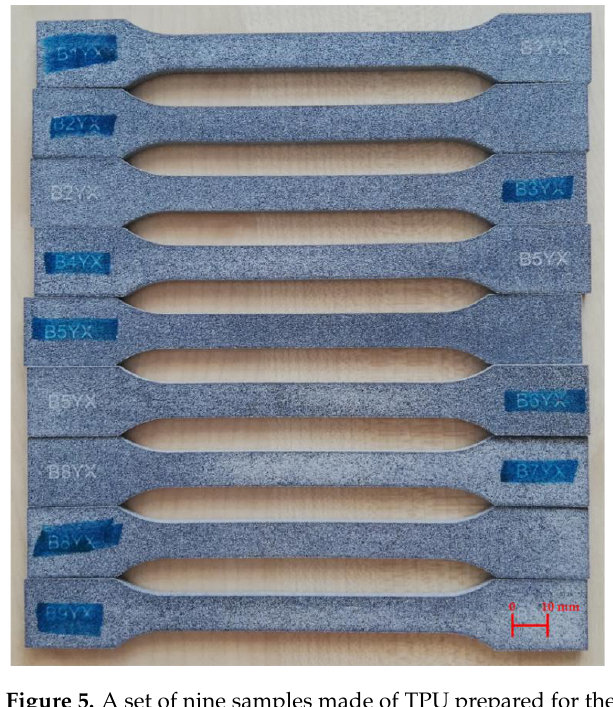
Figure 5. A set of nine samples made of TPU prepared for the tests.